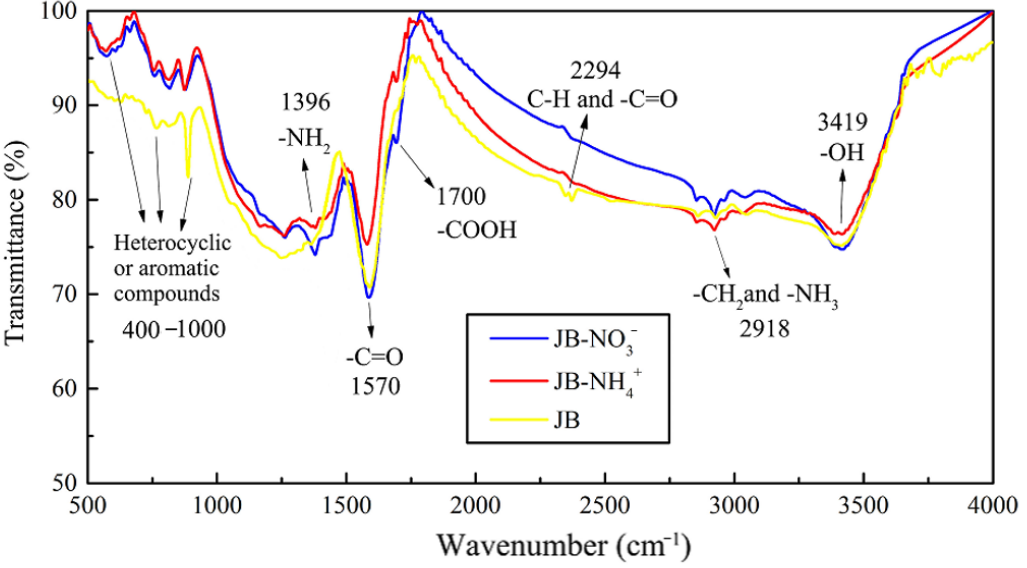
Figure 12. FTIR spectrograms of JB and after the absorption of NO 3 − and NH 4 + .